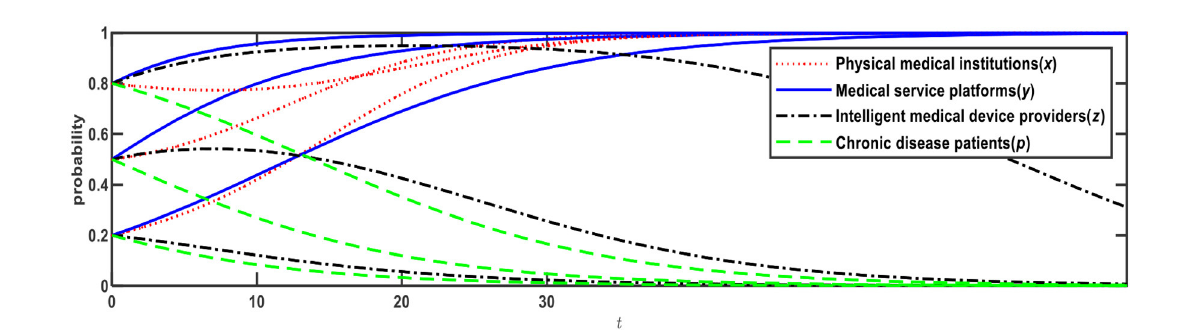
FIGURE7 Evolution of E11